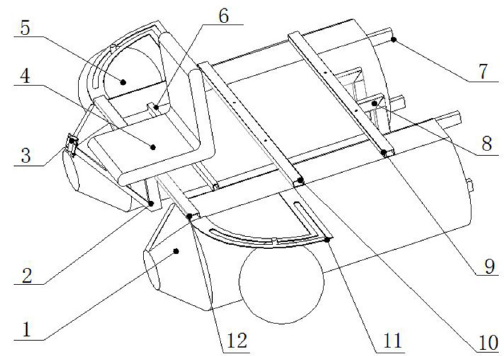
Figure 2. The frame structure of the digging machine: (1) pontoon, (2) drive wheel bracket, (3) fixed clip, (4) seat, (5) float, (6) seat rear support square tube, (7) guide rail, (8) hanging rod, (9) unit rear support square tube, (10) unit front support square tube, (11) float guide, (12) seat front support square